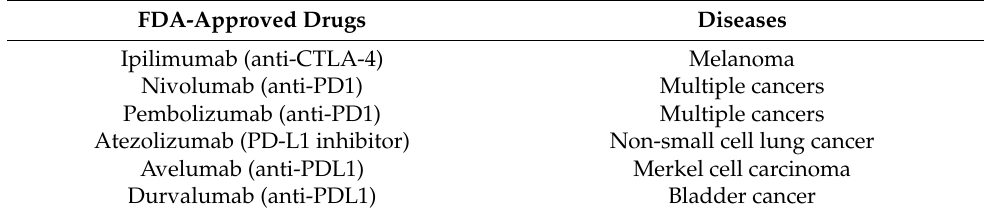
Table 1. FDA-approved immune checkpoint